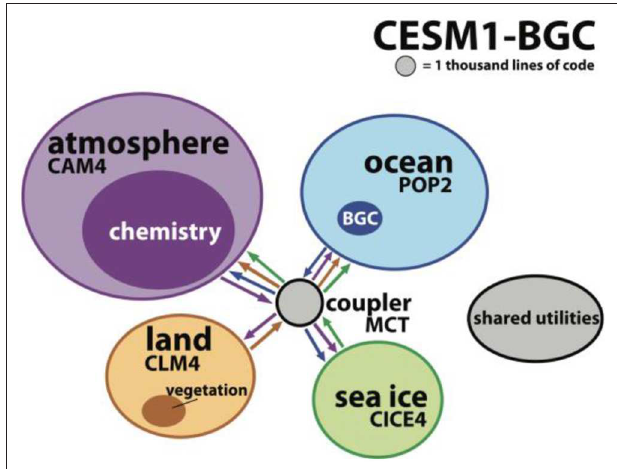
FIGURE 1 | The software architecture of the Community Earth System Model (CESM), taken from Alexander and Easterbrook (2015) and reproduced with the permission of the